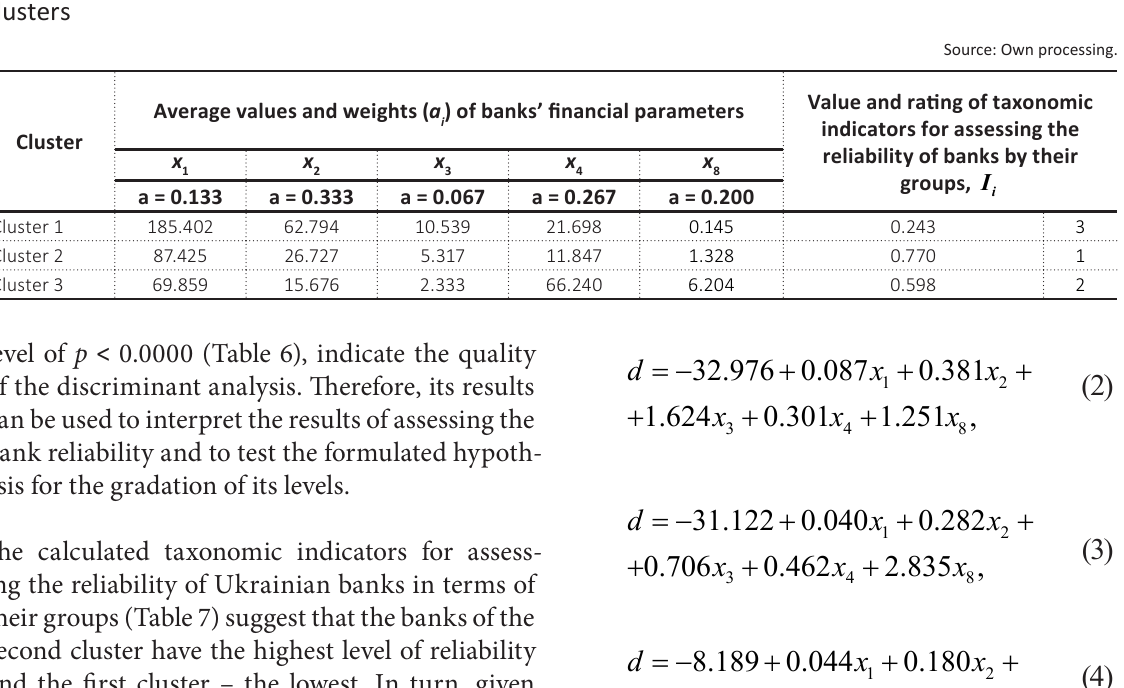
Table 6. Discriminant analysis summary